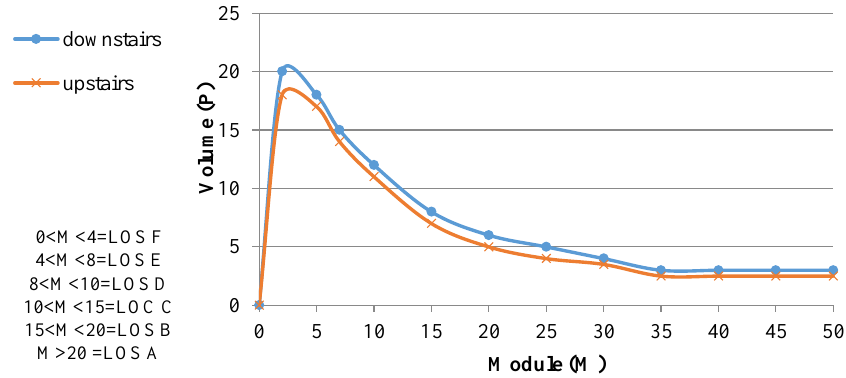
Figure 1. LOS for stairways (volume versus module) in accordance with Fruin theory.